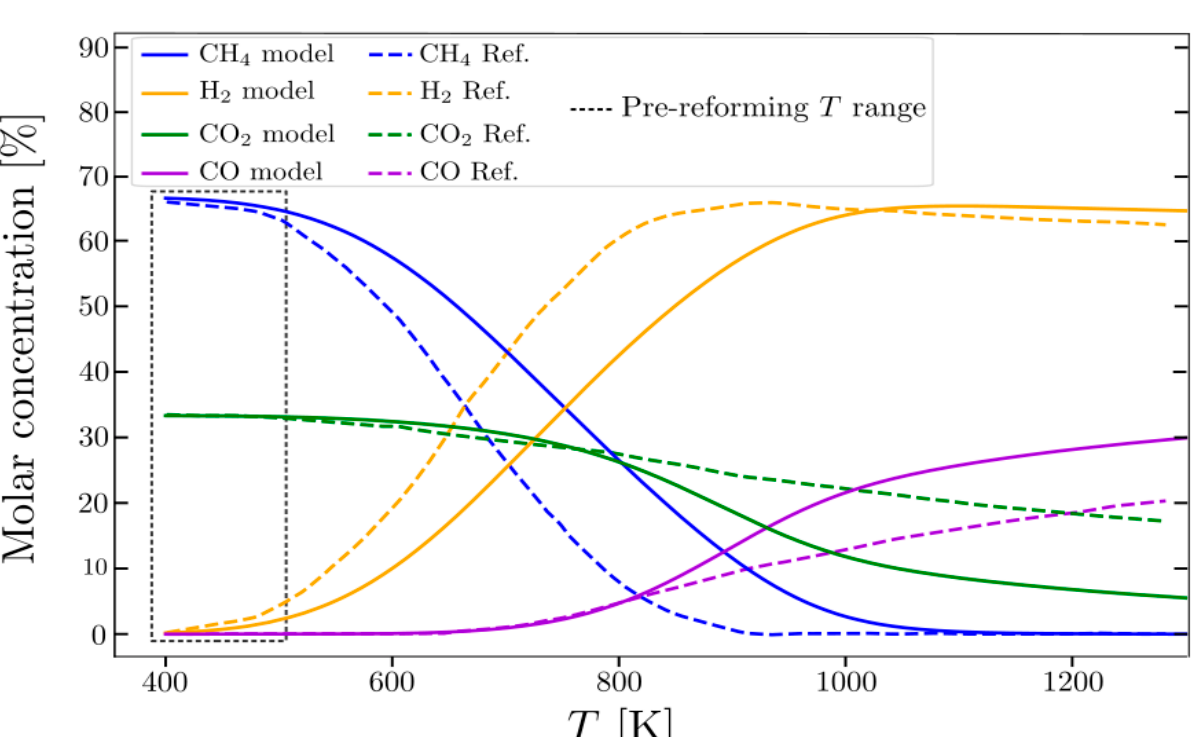
Figure 2. Acetic acid reforming: comparison between the results of the implemented model (solid) and the reported results from [39].